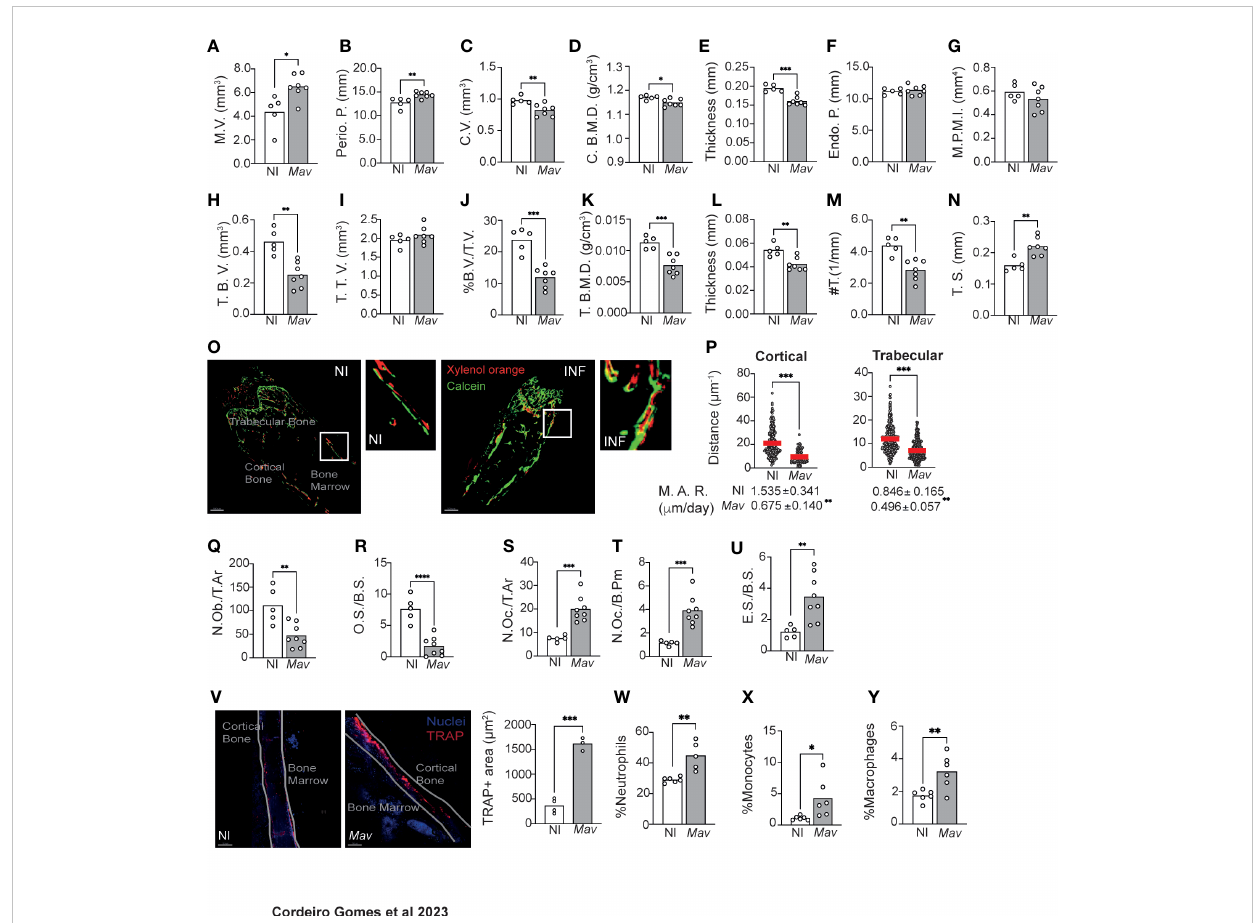
FIGURE 1 Mycobacterium avium infection alters bone turnover, reducing bone mass. (A – G) Measurement of the marrow volume (M.V., (A) , periosteal perimeter (Perio. P., (B) , cortical volume (C.V., (C) , cortical bone mineral density (C. B. M. D., (D) , cortical thickness (E) , endocortical perimeter (Endo. P., (C) , and polar mean moment of inertia (M. P. M. I., (G) in M. avium -infected mice ( Mav bars) compared to non-infected littermate controls (NI bars). (H – N) Measurement of the trabecular bone volume (T.B.V., (H) , trabecular tissue volume (T.T.V., (I) , ratio of bone volume to tissue volume (% B.V./T.V., (J) , trabecular bone mineral density (T. (B) M. D., (F) , trabecular thickness (L) , trabecular number (#T, (M) and trabecular separation (T.S.,